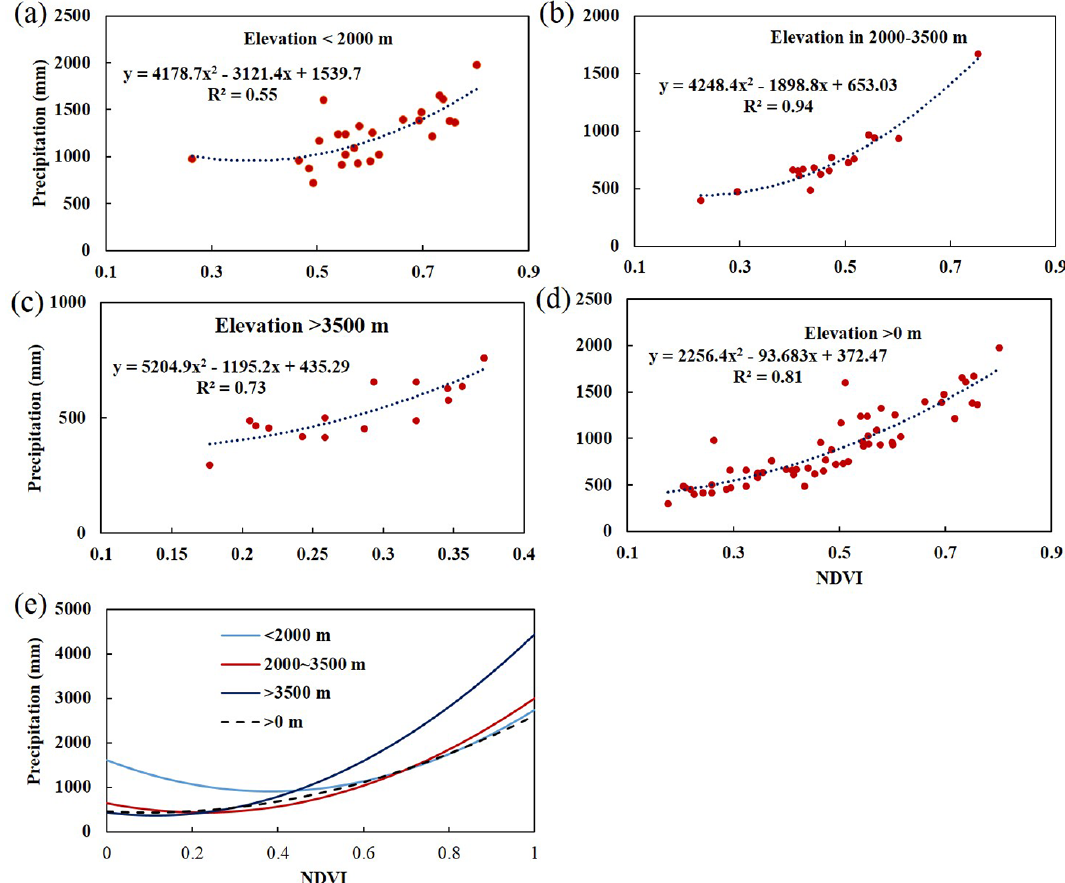
Figure 7. The relationship between mean annual precipitation and NDVI at different elevation bands: (a) elevation band: <200m; (b) band: 2000–3500m; (c) band: >3500m; (d) whole bands; (e) comparison of the precipitation–NDVI relationship for different